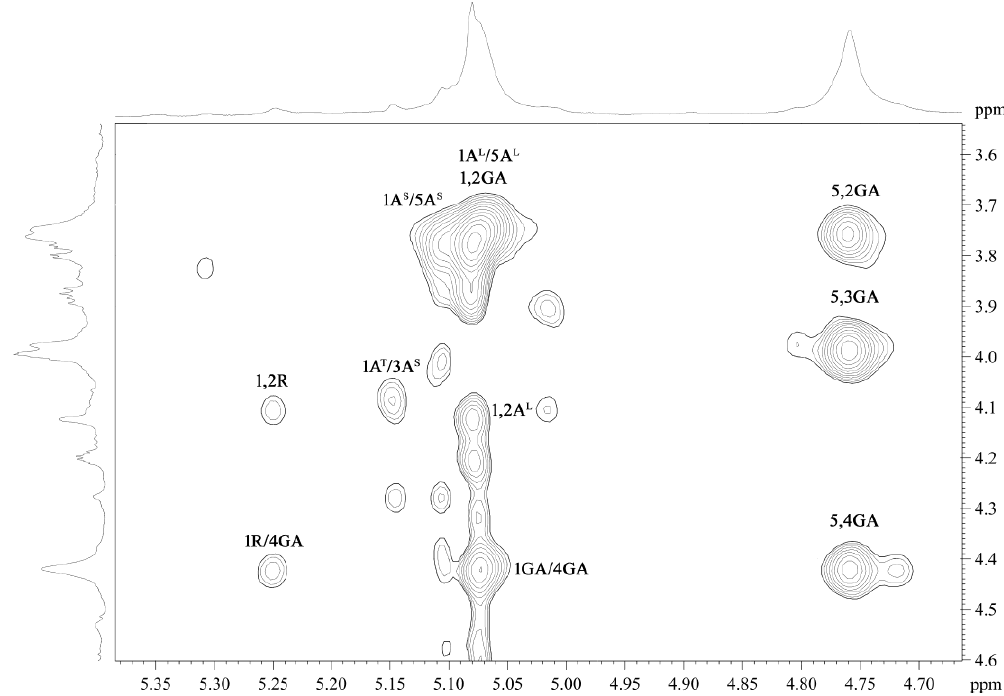
Figure 6. Part of 1 H, 1 H ROESY spectrum of the SO1-1 . The corresponding part of the 1 H NMR spectrum is shown along the axes. Slashes refer to inter-residue correlation peaks, as designated in Table 2.